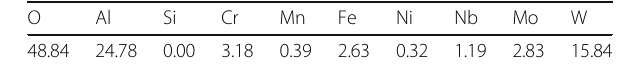
Table 3 Average composition of the bright W-rich particles inside the scale of W5 by EDS (at.